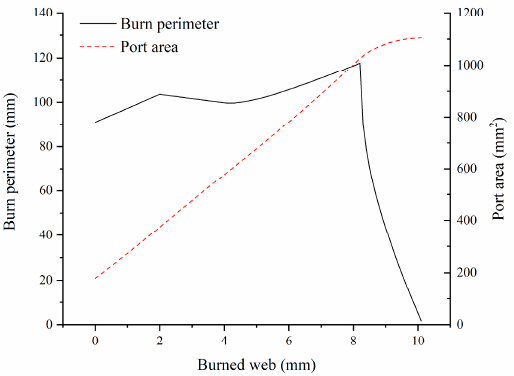
Figure 5. Burn perimeter and port area as functions of burned web.